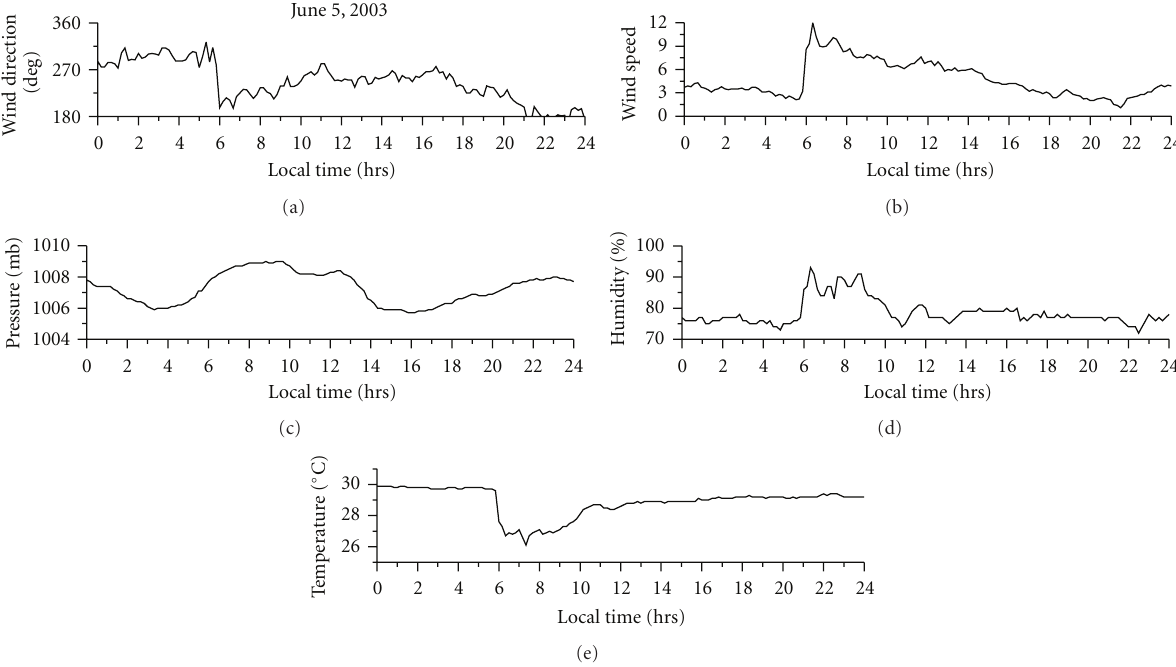
Figure 8: Diurnal variation of meteorological parameters on June 5,